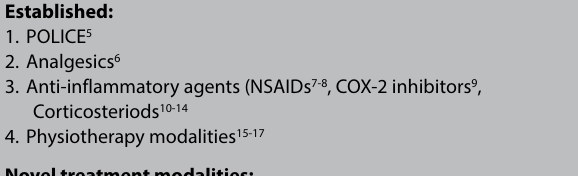
Table 1: Established and novel treatment modalities for soft tissue injuries Established: 1. POLICE